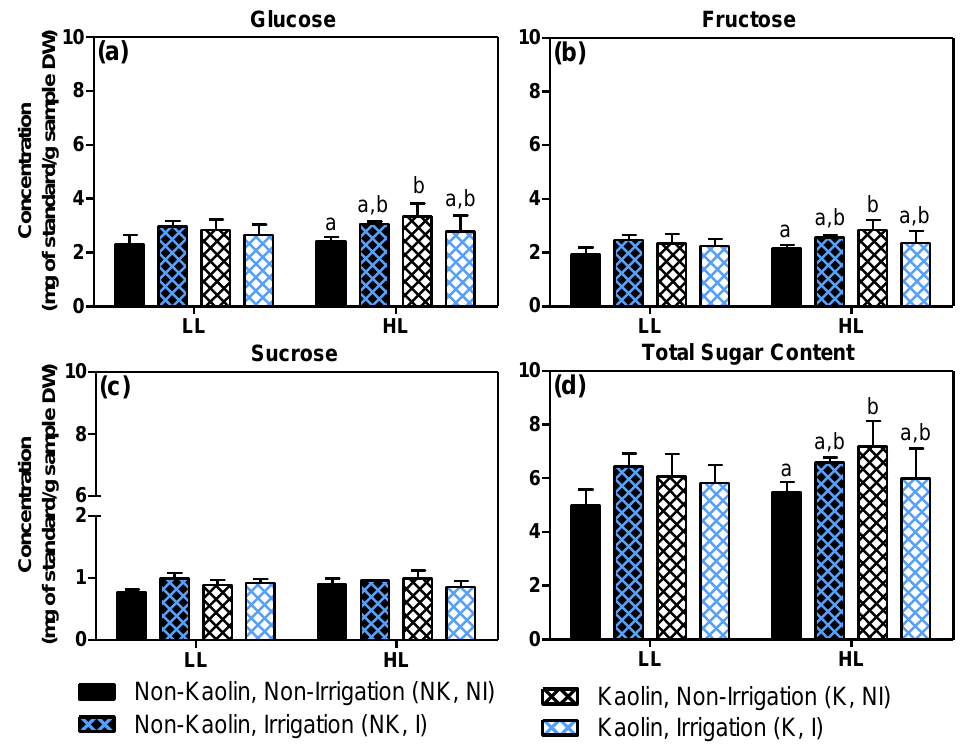
Figure 11. Levels of main sugars (in mg/g sample DW, mean values n = 3–4, +SD) in the exocarp of mature berries grown in either low light (LL) or high light (HL) microclimate conditions in the canopy: ( a ) glucose, ( b ) fructose, ( c ) sucrose and ( d ) their summed values, in this paper referred to as total sugar content. Kaolin (K) or no kaolin (NK) was applied to the plant leaves before fruit set; plants were irrigated (I) or non-irrigated (NI) after the green stage. Statistical notations above the bars: the lowercase letters refer to differences between treatment combinations within the same light microclimate (values with a common letter or no letter at all, indicate no significant differences; two-way ANOVA, p ≤